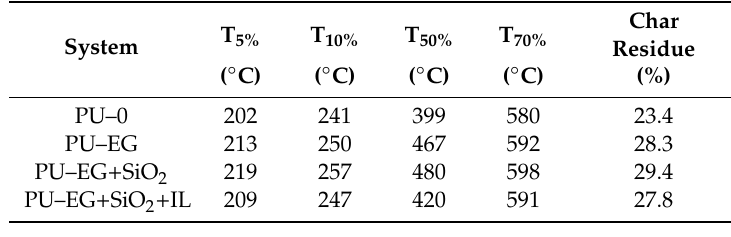
Table 6. Results of the thermogravimetric analysis of PU foams.